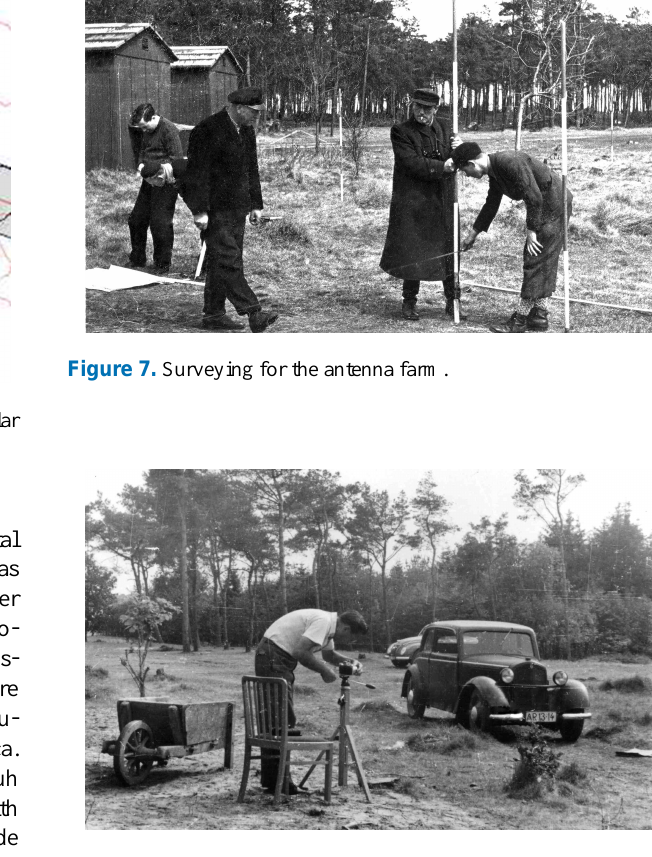
Figure 8. Surveying for the antenna